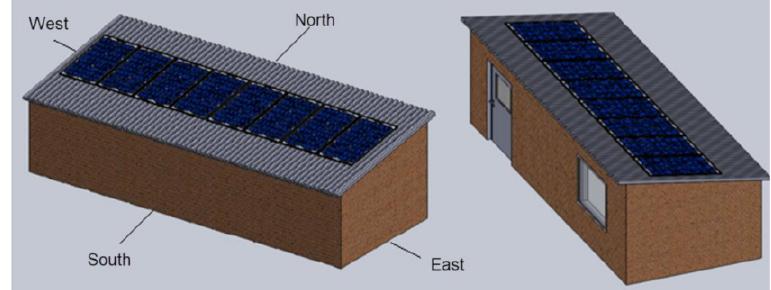
Figure 4. Three-dimensional view of the building with installed PV modules.